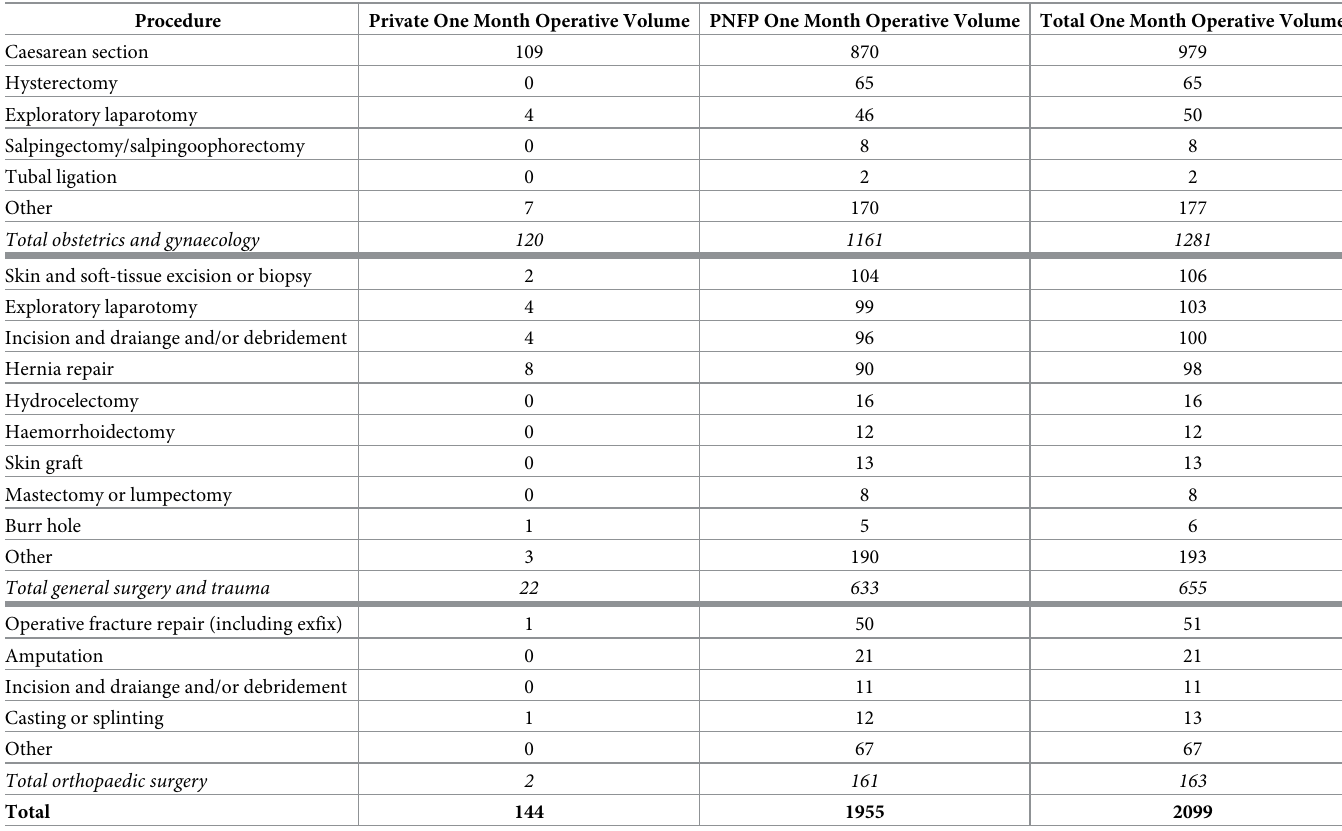
Table 2. Operative